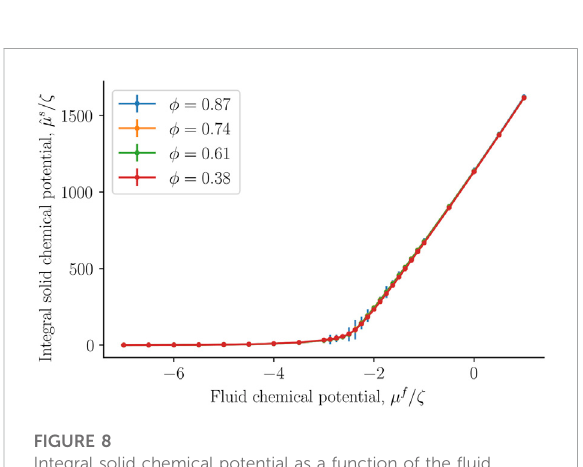
FIGURE 8 Integral solid chemical potential as a function of the fl uid chemical potential μ f at varying porosities ϕ = V f / V .